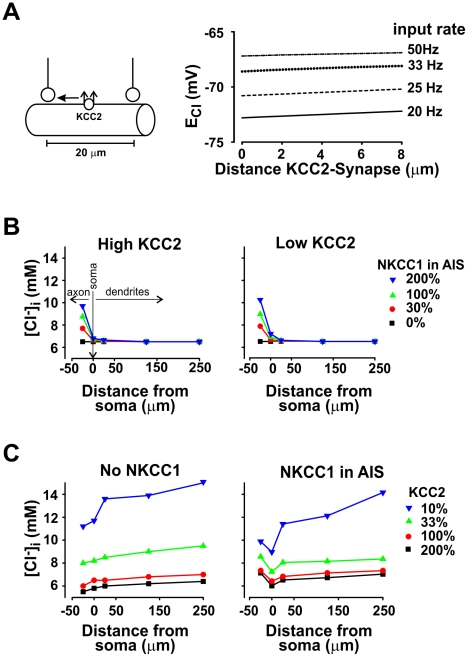
Inhomogenous CCC distribution can create large-scale, but not fine-scale, intracellular [Cl−]i gradients.
A.
left: To investigate whether the perisynaptic distribution of KCC2 can produce fine-scale intracellular [Cl−]i gradients, we varied the subcompartmental distribution of KCC2 by concentrating it in a single location in each compartment at varying distances from a bursting synapse. We divided the compartment into 20 1-µm-long sections. Total amount of KCC2 per compartment was constant at 100%. Inhibitory synapses were located at 20 µm from each other and were activated at high frequency. Right: Results show that the subcompartmental distribution has little impact on the perisynaptic value of E
Cl, which contrasts with the impact of high frequency synaptic input (see Fig. 3) but is consistent with diffusion being responsible for rapid redistribution of intracellular Cl− load. B. In the absence of synaptic activity, we inserted different levels of NKCC1 activity in the axon initial segment (AIS) and monitored the axo-somato-dentritic [Cl−]i gradient for high (100%) and low (33%) levels of KCC2 activity (uniformly distributed, except in the AIS). Soma corresponds to 0 on x-axis; positive distance extends towards dendrites and negative distance extends towards axon, as summarized on left panel. C. In the presence of background synaptic activity (f
inh  =  0.4 Hz; f
exc  =  0.1 Hz) we simulated different levels of KCC2 activity (uniformly distributed, except in the AIS) and monitored the axo-somato-dentritic [Cl−]i gradient in the presence (100%) or absence of NKCC1 in the AIS.